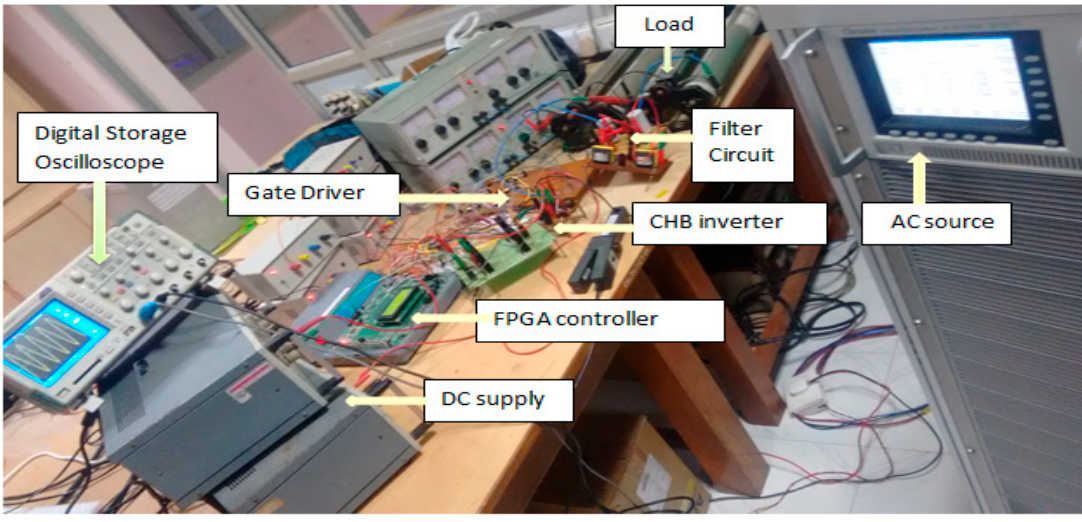
Figure 12. Picture of the experimental set-up.